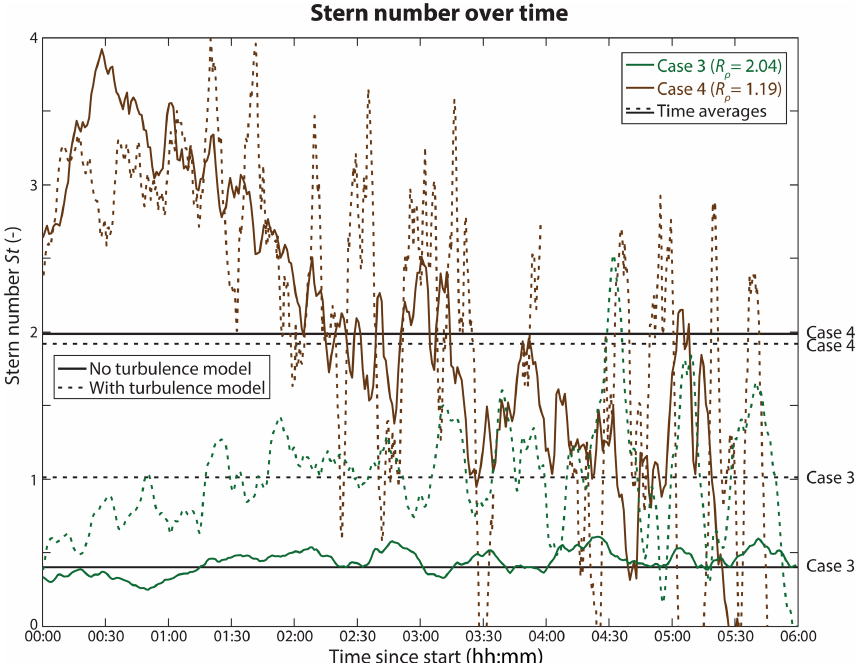
Figure 13. The evolution of the Stern numbers over time for R ρ mark the simulations without a turbulence model, and dotted lines marks the simulations with a turbulence model. The black lines mark the temporal averages for each